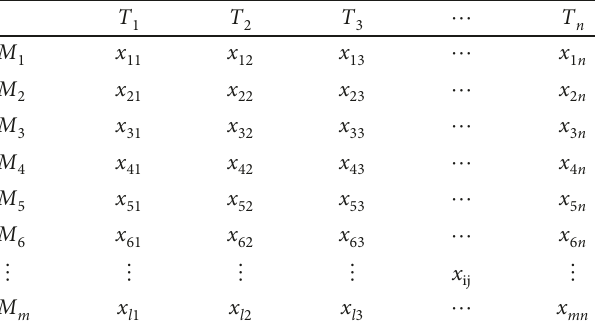
Table 2: The decision table of WTA.